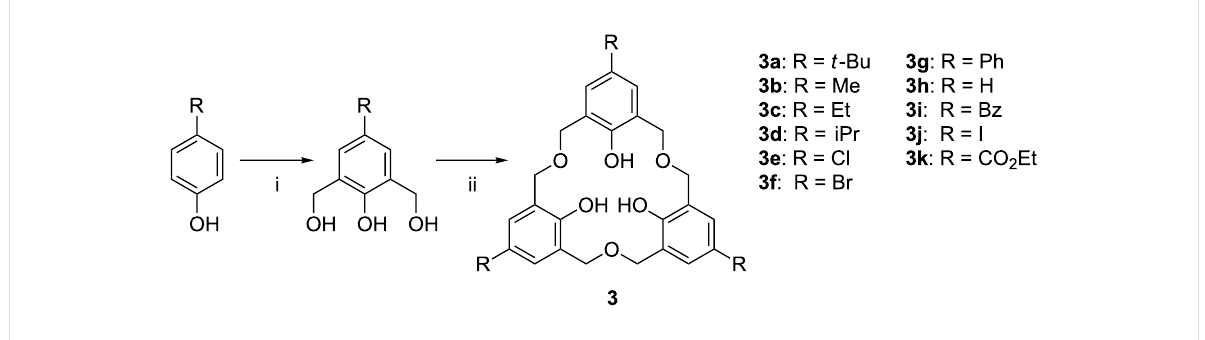
Scheme 1: Synthesis of oxacalix[3]arenes: (i) Formaldehyde (37% aq), NaOH (aq), 1,4-dioxane; glacial acetic acid, acetone; (ii) refluxing o -xylene [14] or Na 2 SO 4 , MsOH, in refluxing DME [15].